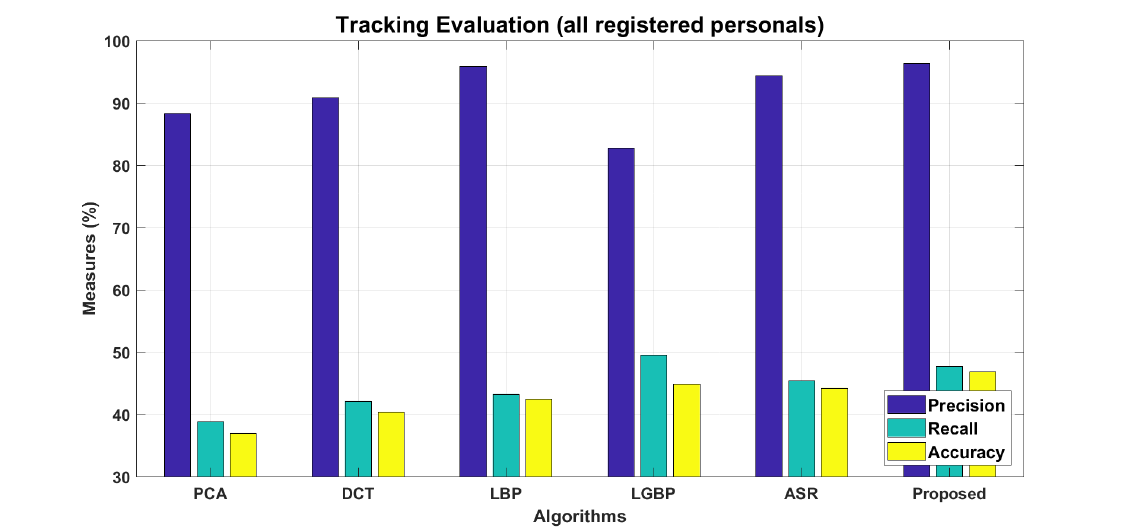
Figure 19. Evaluation summary of temporal tracking for all registered